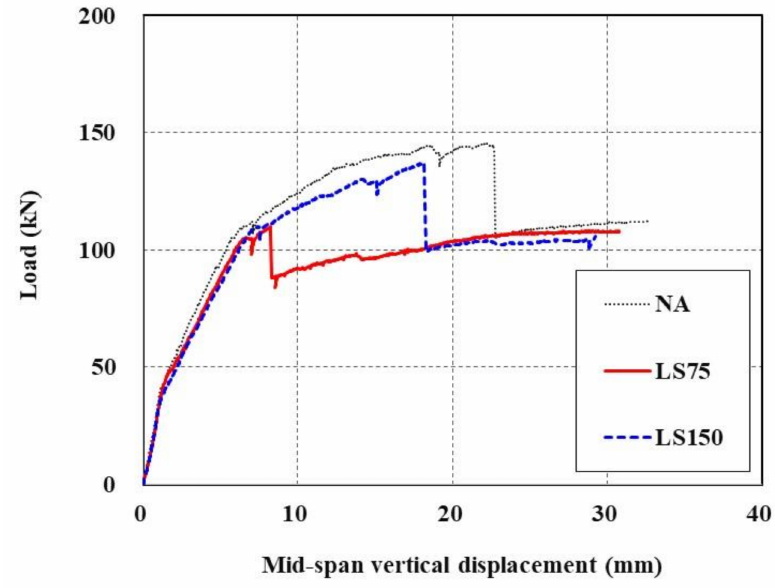
Figure 15. Load-displacement curves of TRC-strengthened RC slabs with (LS75 and LS150) and without lap splicing